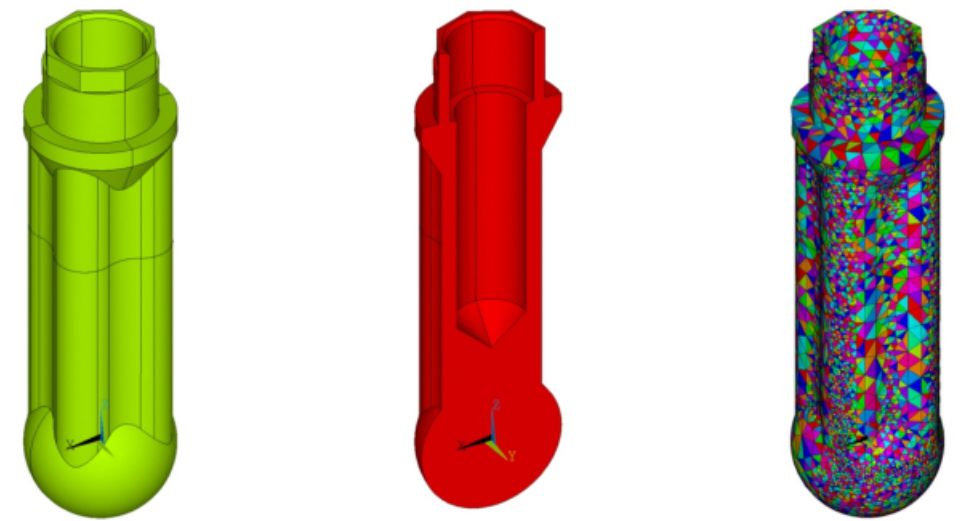
Figure 1. 3D model of the designed implant 0001 (ANSYS APDL): whole 3D model (left), longitudinal section (middle) and FEM mesh (right).